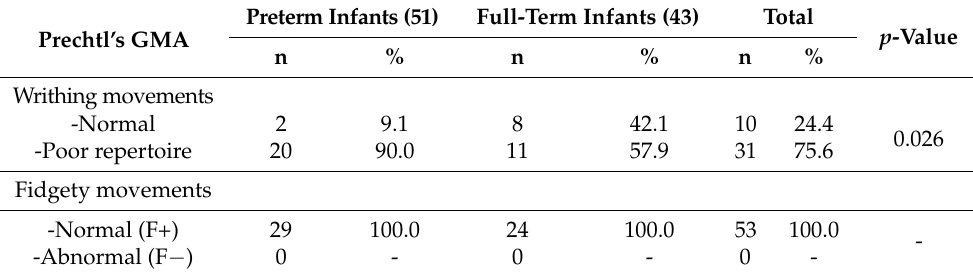
Table 2. Prechtl’s general movements assessment of all preterm and full-term